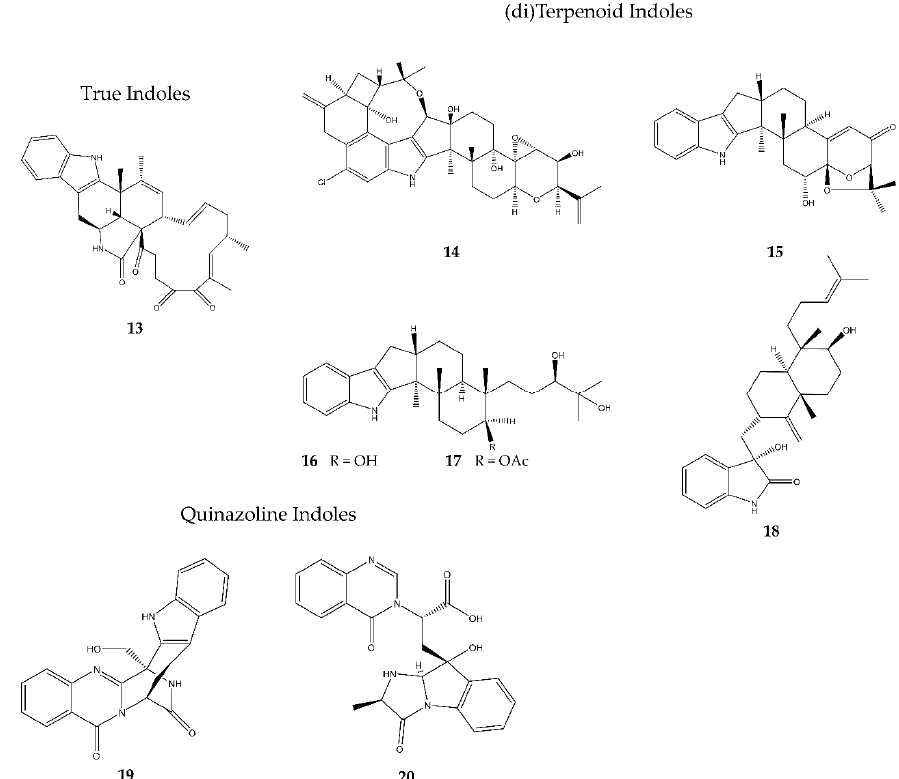
Figure 4. Overview of the different antimicrobial indoles discovered in marine fungi since 2015, divided into three structural classes (true indoles, (di)terpenoid indoles, and quinazoline indoles). In total, eight compounds were discovered, being penochalasin K ( 13 ), 19-hydroxypenitrem A ( 14 ), 6-hydroxylpaspalinine ( 15 ), penijanthine C–D ( 16 – 17 ), (3 R ,9 S ,12 R ,13 S ,17 S ,18 S )-2-carbonyl-3-hydroxylemeniveol ( 18 ), fumigatoside E ( 19 ), and fumigatoside F ( 20 ).